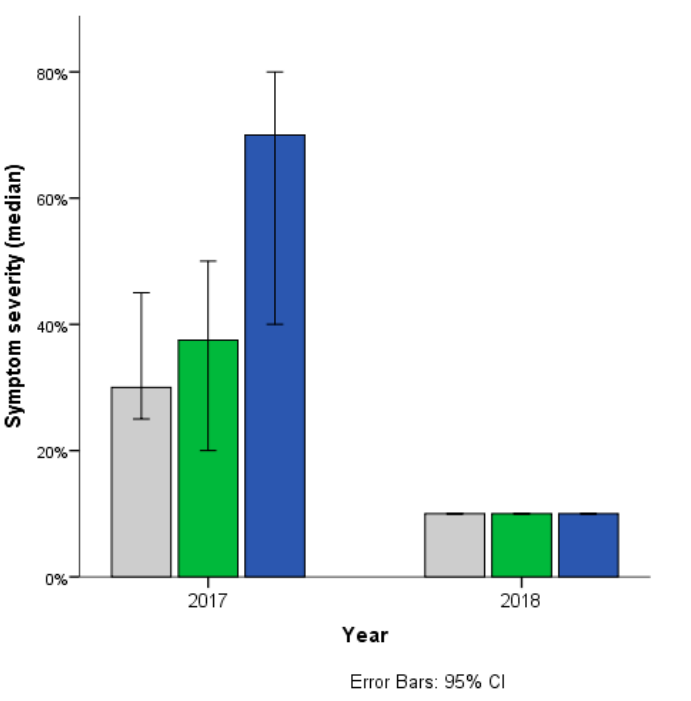
Figure 3. Symptom severity of Streptomyces sp. infection with three treatments, assessed in 2017 and 2018. Treatments: PPS contains Pseudomonas protegens , Pseudomonas jessenii , and Stenotrophomonas maltophilia ; TPB contains Trichoderma atroviride , Pseudomonas putida , and Bacillus subtilis . The horizontal (X) axis shows the study years, while on the vertical (Y) axis, the symptoms in the percentage of the total yield values are shown. n = 40 in each group in 2017; and control n = 160, PPS n = 218 TPB, n = 247 in 2018.